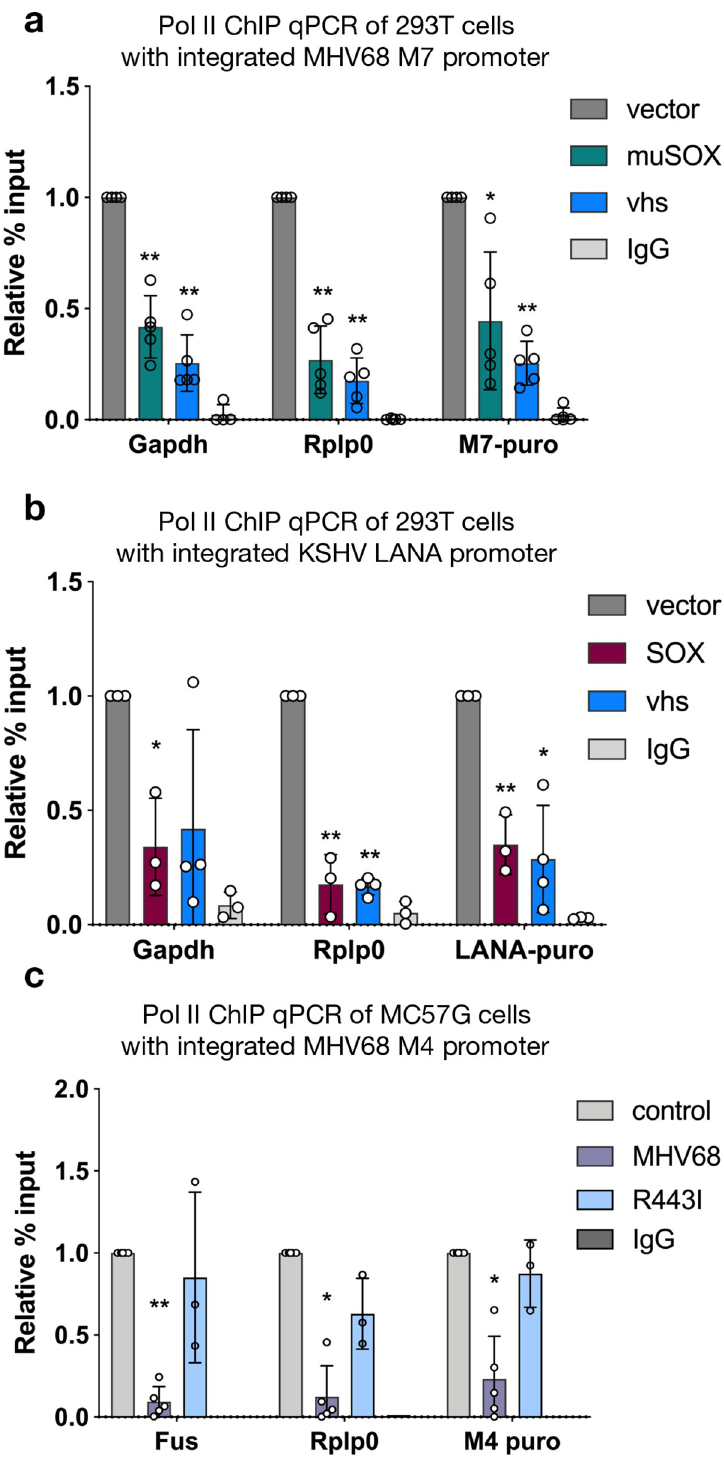
Fig 6. Viral promoter sequences are insufficient to escape transcriptional regulation. (A) The MHV68 M7 viral promoter driving puromycin resistance was lentivirally integrated into 293T cells. 24 h post transfection of muSOX or vhs, Pol II-ChIP qPCR was used to measure Pol II levels at two host promoters ( Gapdh , Rplp0 ) and the integrated M7 promoter. ( � p < 0.05, �� p < 0.001, students paired t-test on raw % input values plotted with standard deviation) (B) The KSHV LANA promoter driving puromycin resistance was integrated into 293T cells by random incorporation.